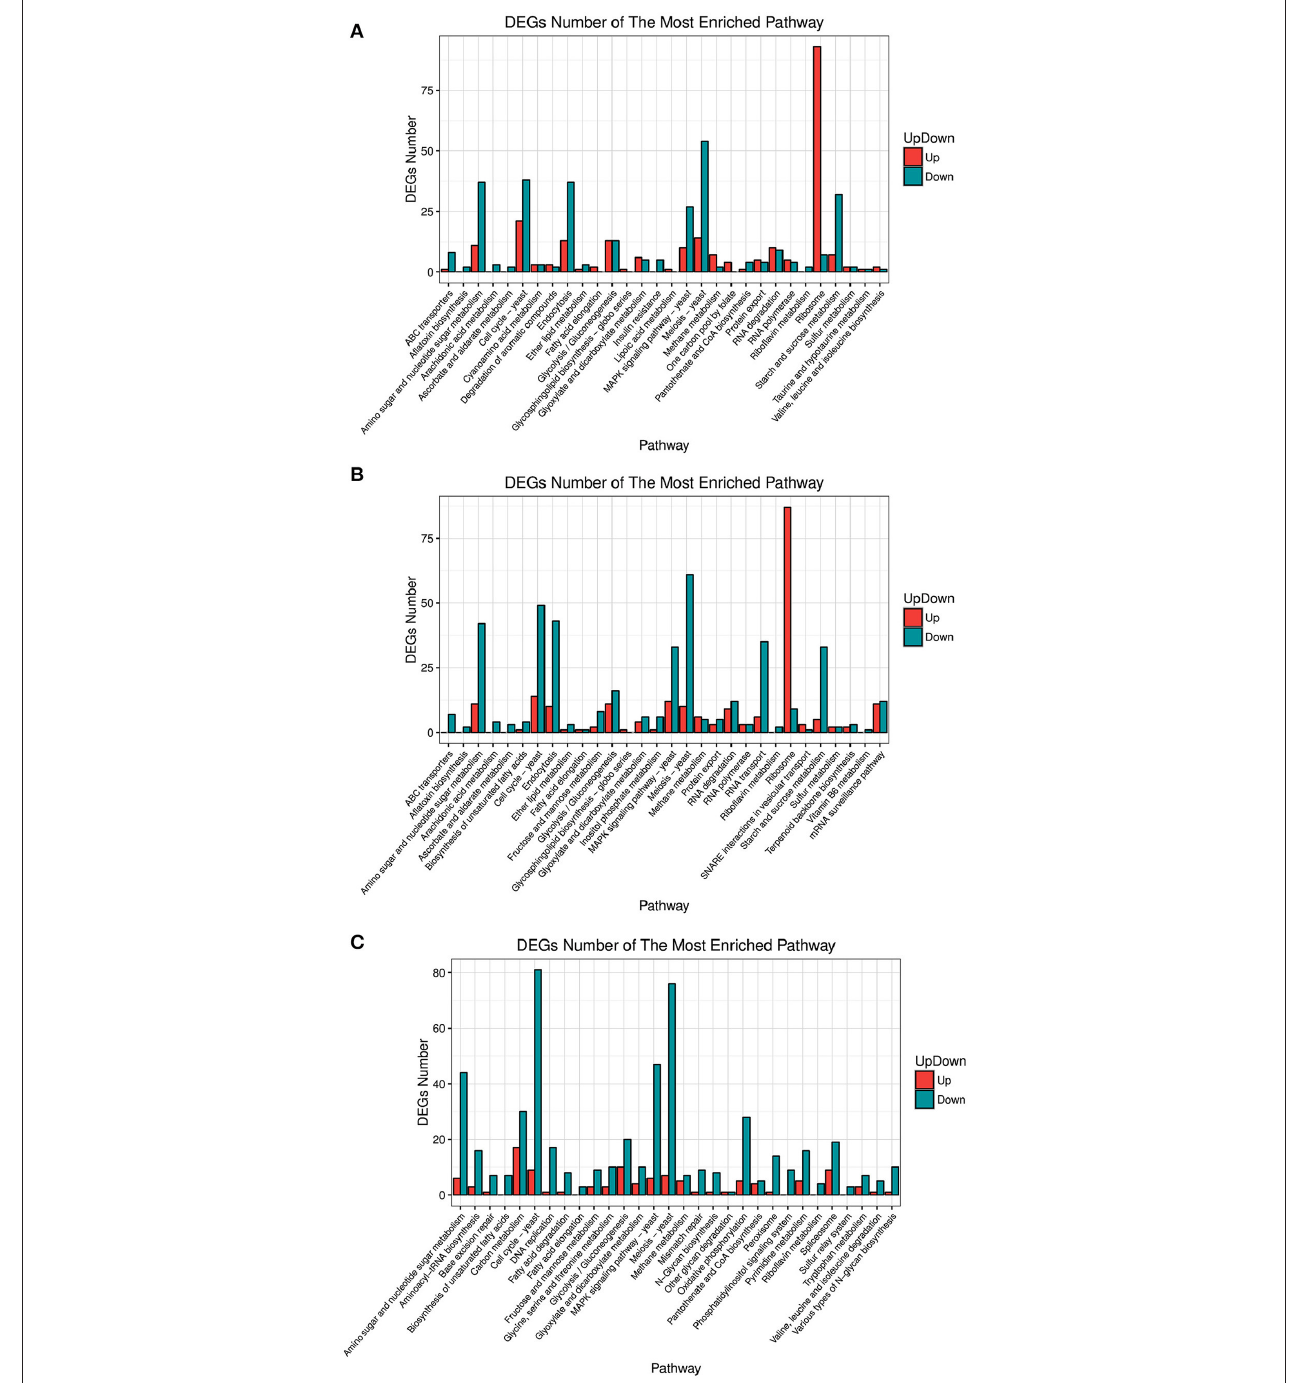
FIGURE 4 | Pathway enrichment of different expression genes between FZF1 transformed strains and A9 with Gene Ontology (GO) interpretation. (A) A9-FZF1-u vs. A9; (B) A9-FZF1-e vs. A9; (C) A9-FZF1-u-s vs. A9.